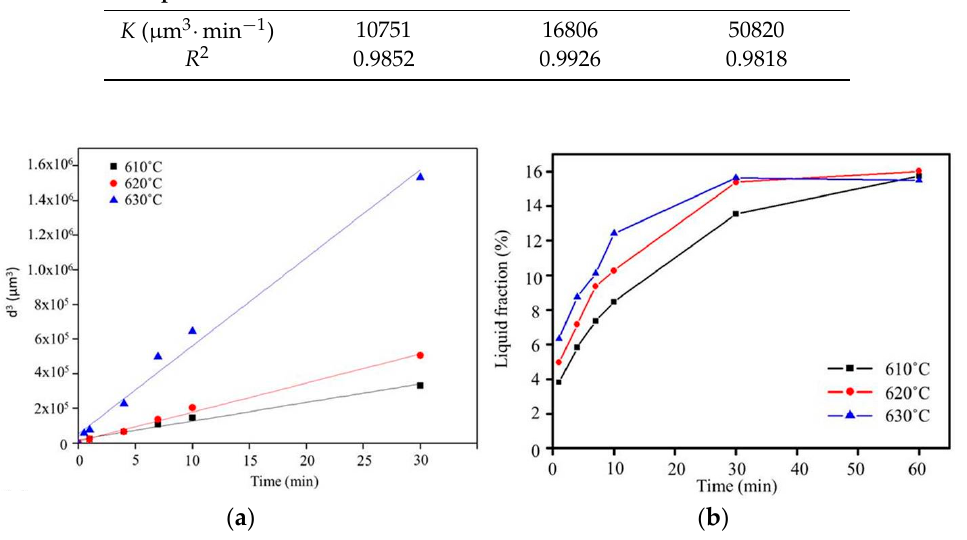
Figure 7. ( a ) Plot of grain size versus salt bath duration from Lifshitz-Slyozov-Wagner (LSW) theory (Ex3) and ( b ) liquid fraction for various salt bath temperatures (Ex3).